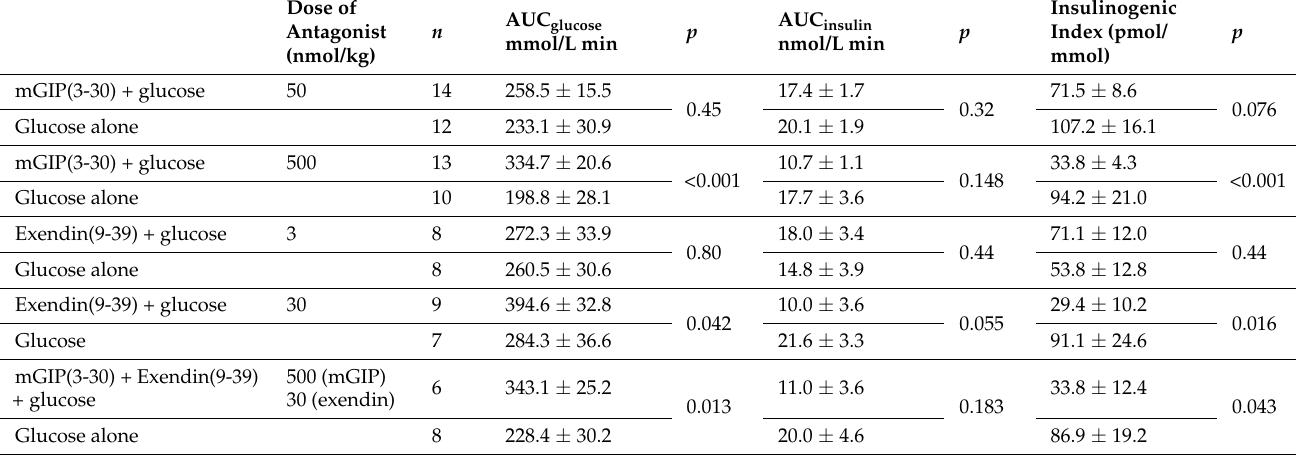
Figure 1. Glucose and insulin levels and individual data points for AUC glucose , AUC insulin and insulinogenic index after intravenous administration of the GIP receptor antagonist mGIP(3-30) (500 nmol/kg) or saline four minutes after an oral administration of 50 mg glucose in normal mice. Means ± SEM are shown. Asterisks indicate the probability level of random difference between mGIP(3-30) versus the glucose control; * p < 0.05; ** p < 0.01; exact p levels see results section; n indicates number of animals. Table 1. AUC glucose , AUC insulin and insulinogenic index after intravenous administration of the GIP receptor antagonist mGIP(3-30) (50 or 500 nmol/kg), the GLP-1 receptor antagonist exendin(9-39) (3 or 30 nmol/kg), the combination of mGIP(3-30) (500 nmol/kg) and exendin(9-39) (30 nmol/kg), or saline (= glucose alone) four minutes after oral administration of 50 mg glucose in normal mice. Means ± SEM are shown. n indicates number of animals in each group; p indicates the probability level of random difference between the experimental groups.